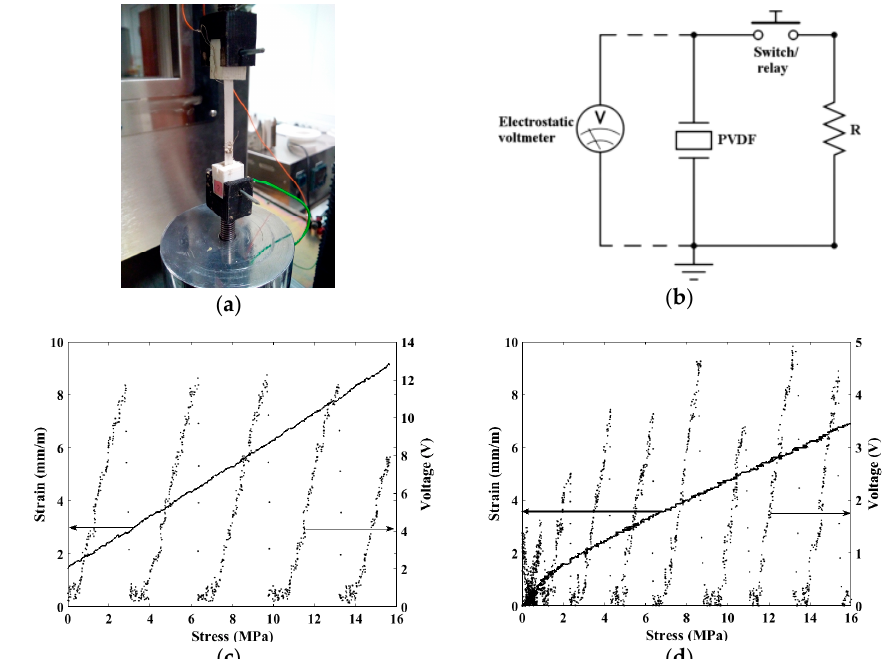
Figure 2. ( a ) Picture of a mounted polymer ready to use in the tensile machine. Electrodes are connected to the contactless electrostatic voltmeter and the open-circuit voltage is recorded (Labview software); ( b ) Schematic of the voltage measurement; ( c ) Strain-Stress curve and open-circuit output voltage for PLLA sample; ( d ) Strain-Stress curve and open-circuit output voltage for PVDF sample.